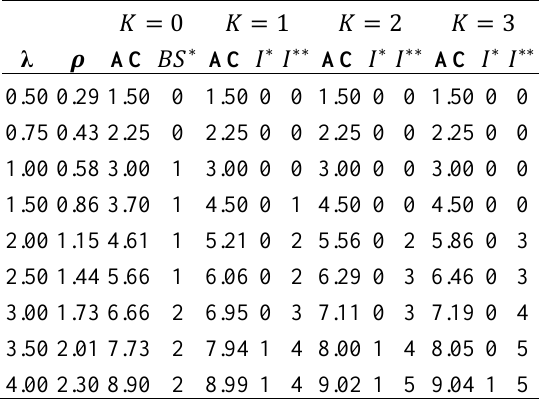
Table 3. Optimal policy parameters, 𝑠 = 1 𝐾 = 0 𝐾 = 1 𝐾 = 2 𝐾 = 3 λ